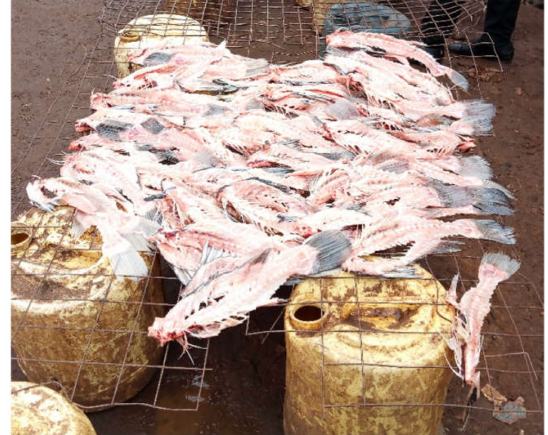
Figure 4. A photo of fish being sold in the informal